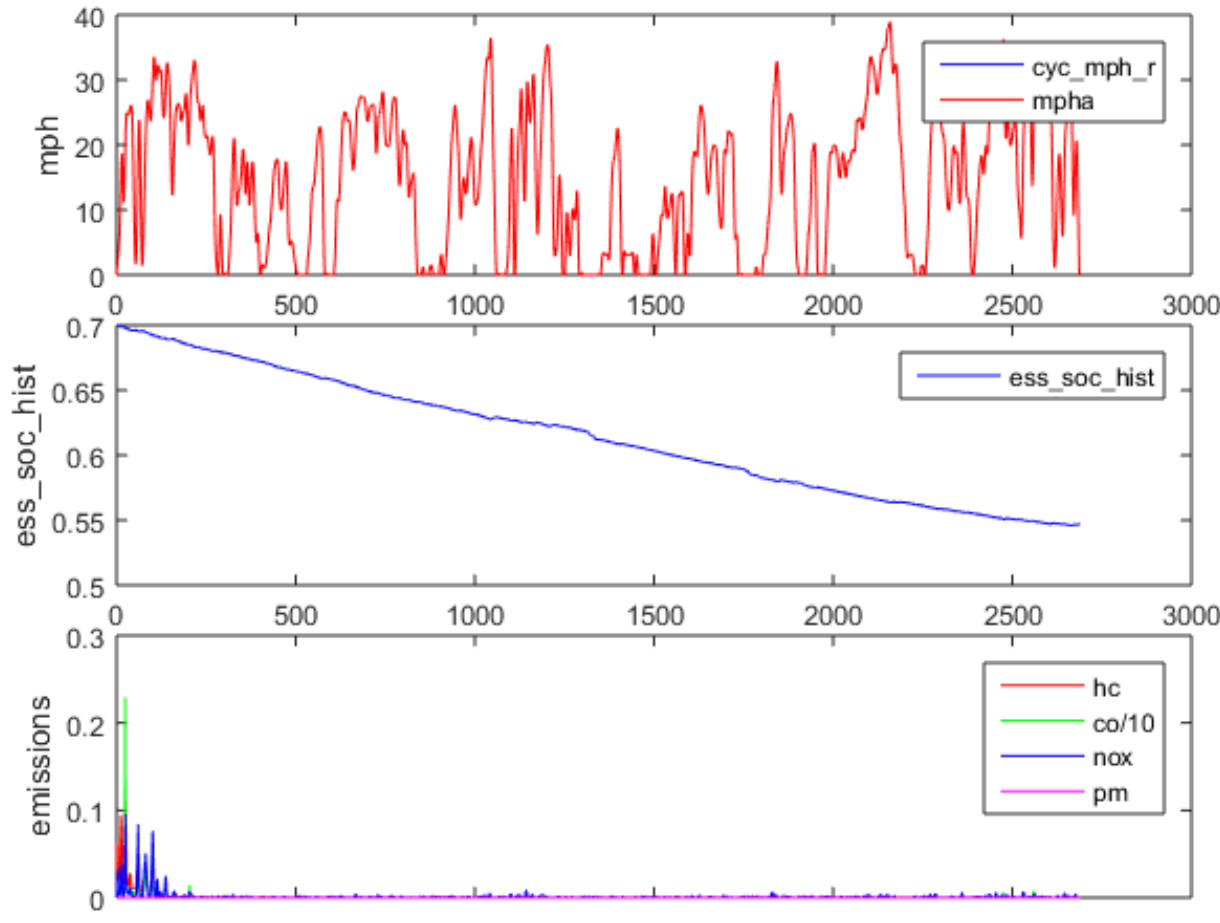
Figure 12. SOC and emissions before optimization.